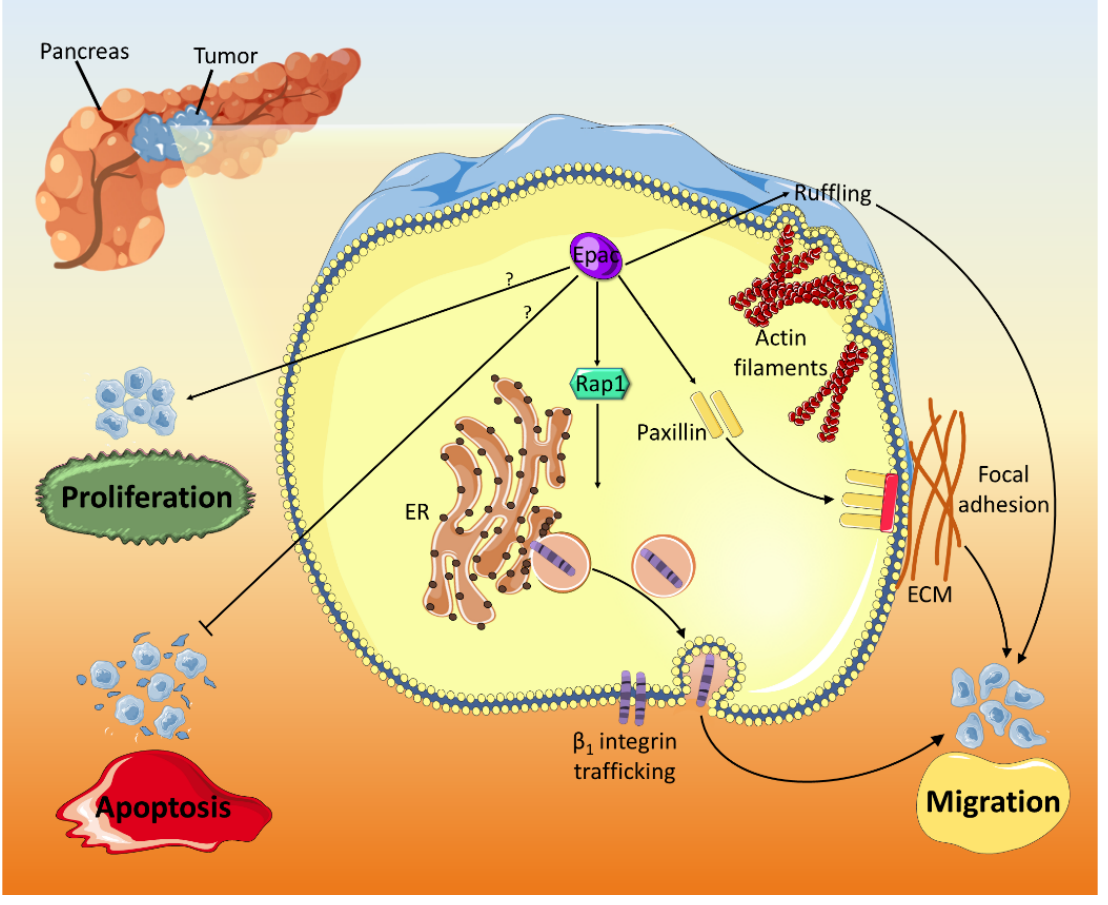
Figure 6. Epac has a positive role in pancreatic cancer progression. Epac increases cell ruffling and enhances the accumulation of paxillin near focal adhesion points to aid in their formation. Furthermore, Epac mediates β1 integrin trafficking in pancreatic malignant cells. All three mechanisms (ruffling, formation of new focal adhesions, and β1 integrin trafficking) stimulate cancer cell migration. Epac also promotes proliferation and attenuates apoptosis in pancreatic cancer through mechanisms that are yet to be identified.